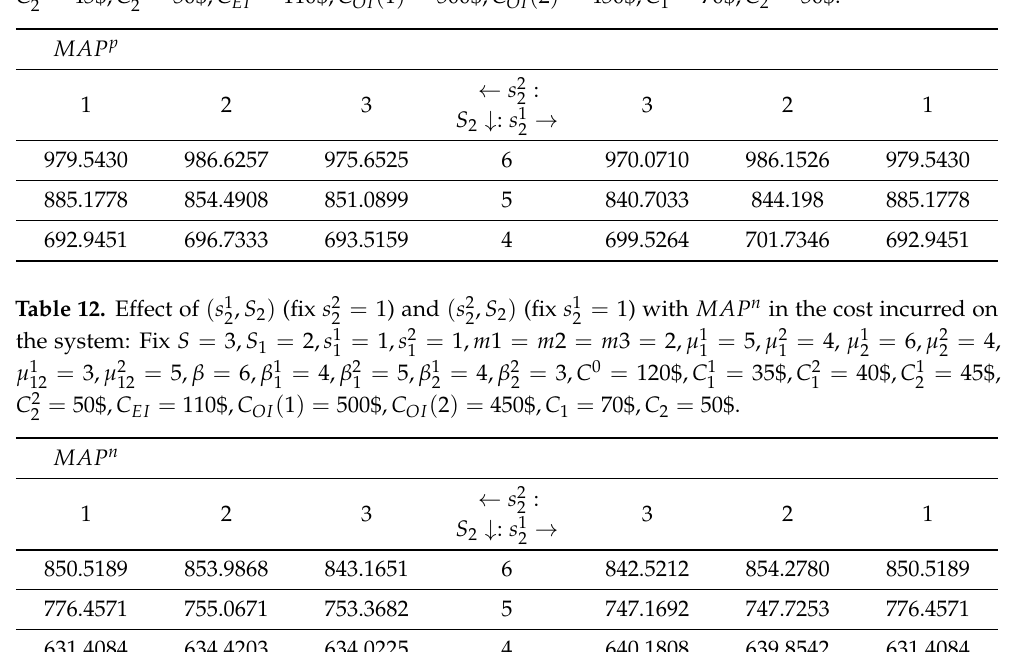
= 1) and ( s 2 , S 2 ) (fix s 2 2 2